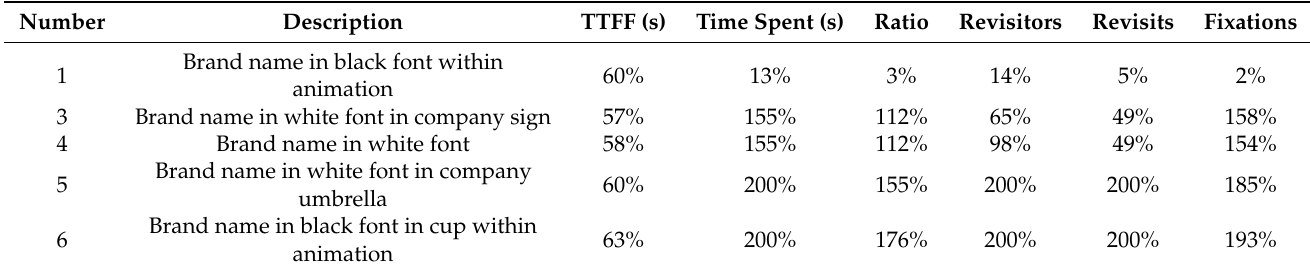
Table 7. New website design: area of interest (AOI) metrics percentage difference against company branch location preview in Table A4. Note: the company branch location preview AOI was removed from the table for relevance purposes, but the order remained the same. Furthermore, percentages were truncated to no decimal places.